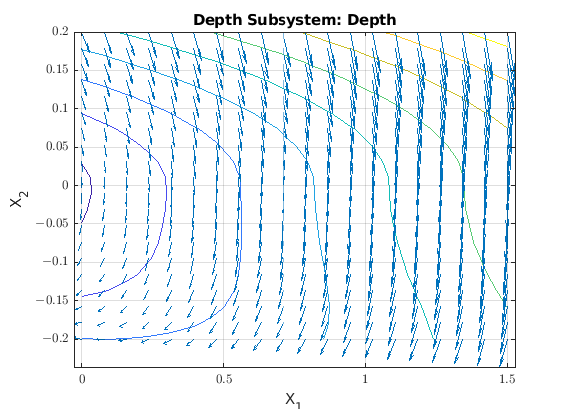
Figure 6. Vector field for displacement in the Z axis where the phase variables are Z and ˙ Z . The limits for Z begin at zero, as this measurement represents